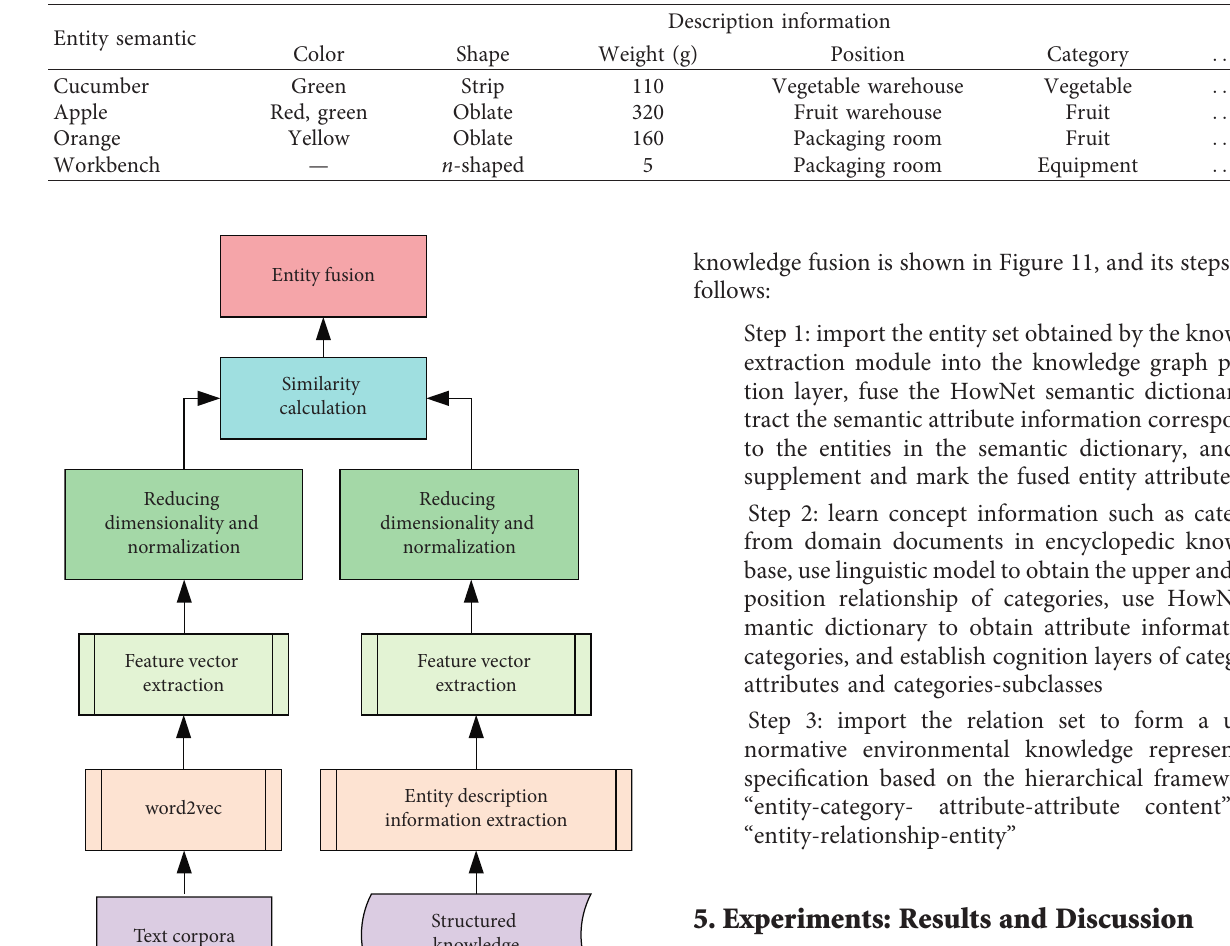
Table 2: Description information of the structural database.